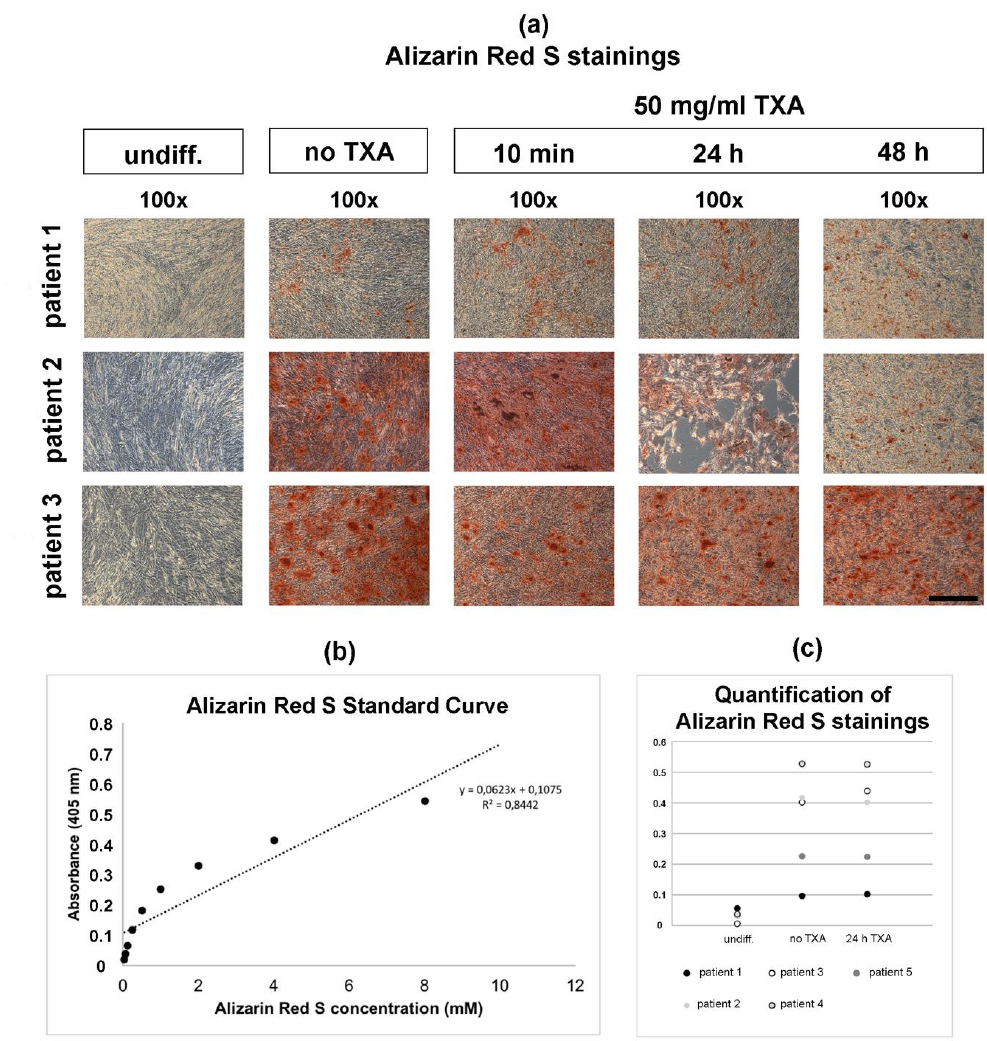
Figure 4. Histological analysis ( a ) of osteogenesis in mesenchymal stromal cells after 21 days in monolayer cell culture and treatment with 50 mg / mL tranexamic acid for varying exposure times. Primary hMSCs were harvested from the bone marrow reaming of three separate patients that underwent total hip arthroplasty. Osteogenic di ff erentiation was induced in hMSCs using an osteogenic di ff erentiation medium for 21 days. Undi ff erentiated control samples (undi ff .) were maintained for comparison. After 21 days of osteogenesis, hMSCs were exposed to no (no TXA), or 50 mg / mL of TXA. Cells were exposed to TXA for 10 min (min), 24 h (24 h) or 48 h (48 h). Alizarin Red S staining was performed to detect extracellular calcium deposits shown as red stainings. Representative samples from three di ff erent donors were captured at low (100x; black bar = 200 µ m) magnification. The Alizarin Red S standard curve was calculated with the quantification assay of Alizarin Red S stainings ( b ). Quantitative measurements of Alizarin Red S stainings ( c ) were performed in undi ff erentiated control samples (undi ff .), di ff erentiated hMSCs (no TXA), as well as di ff erentiated hMSCs after treatment with 50 mg / mL of TXA for 24 h (24 h TXA). Results were pictured as dot plots. hMSCs, human mesenchymal stromal cells; TXA, tranexamic acid; min, minutes; d, days; h,